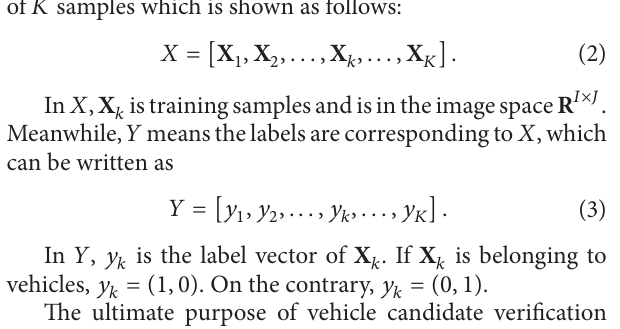
Figure 3: An example of the proposed clustering